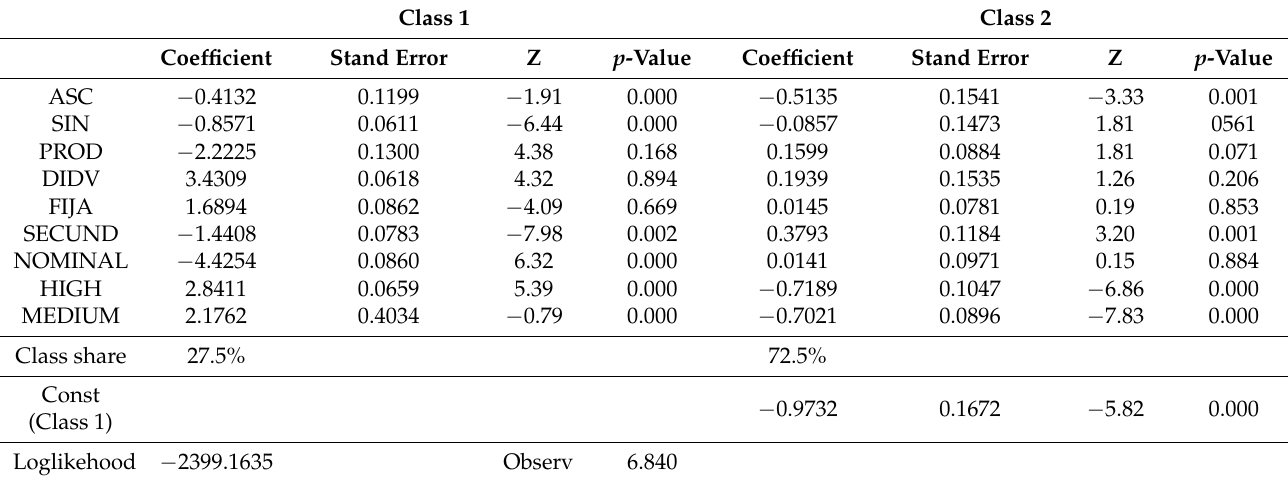
Table 5. Results of the choice experiment with latent